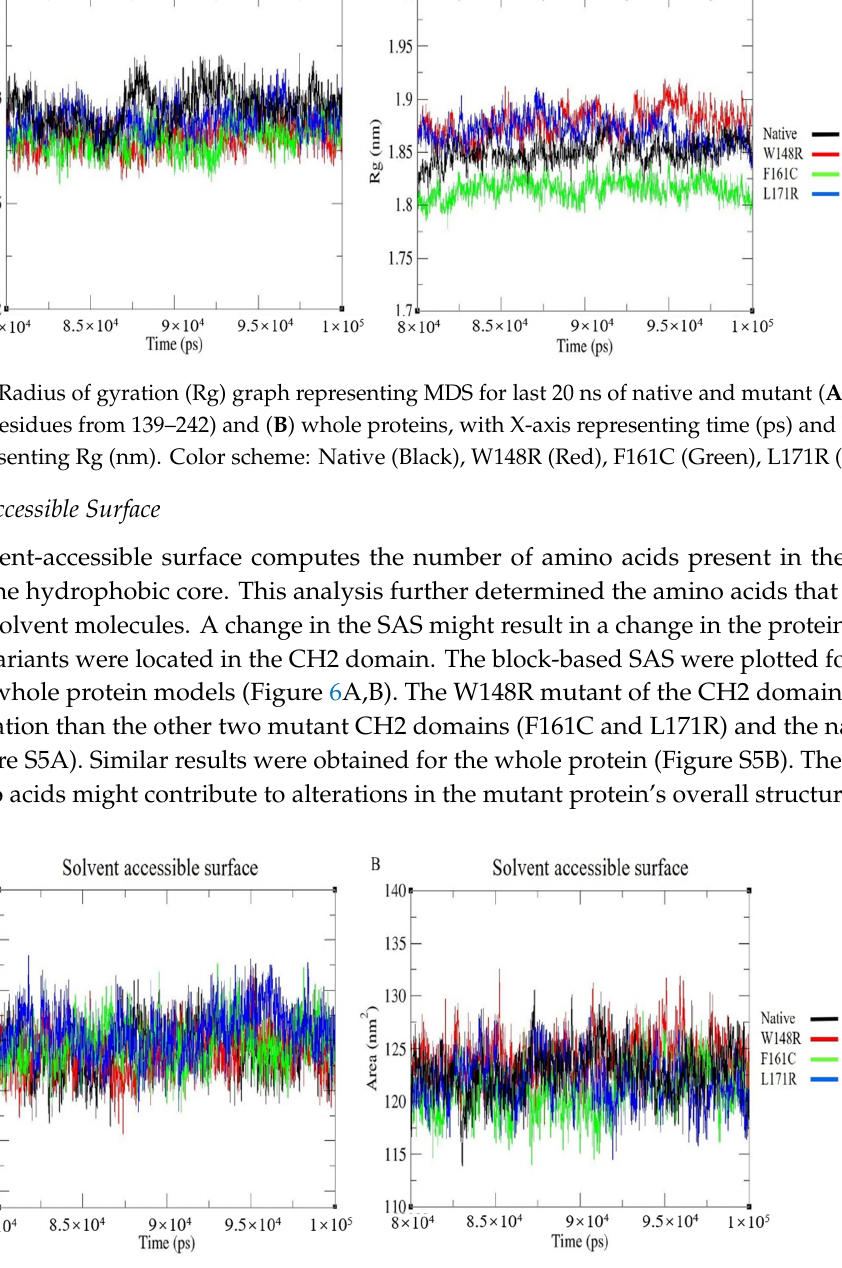
Figure 6. Solvent accessible surface (SAS) graph representing MDS for last 20 ns of native and mutant ( A ) CH2 domain (residues from 139–242) and ( B ) whole proteins, with X-axis representing time (ps) and Y-axis was representing Area (nm 2 ). Color scheme: Native (Black), W148R (Red), F161C (Green), L171R